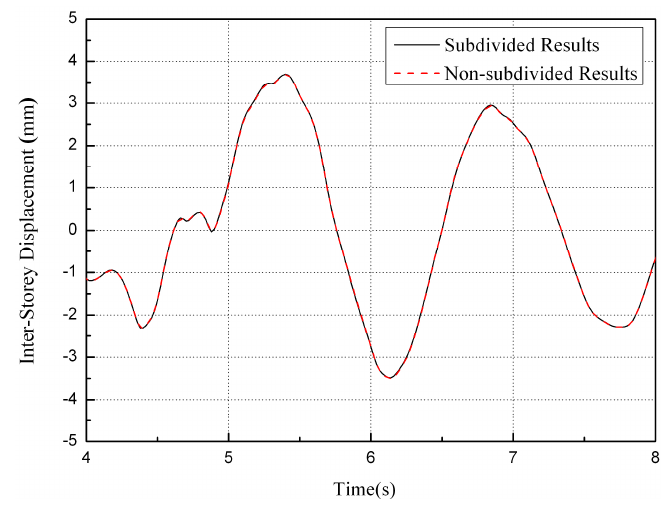
Figure 11. Detailed time history curve of the story drift with different integral steps at 4 s~8 s.